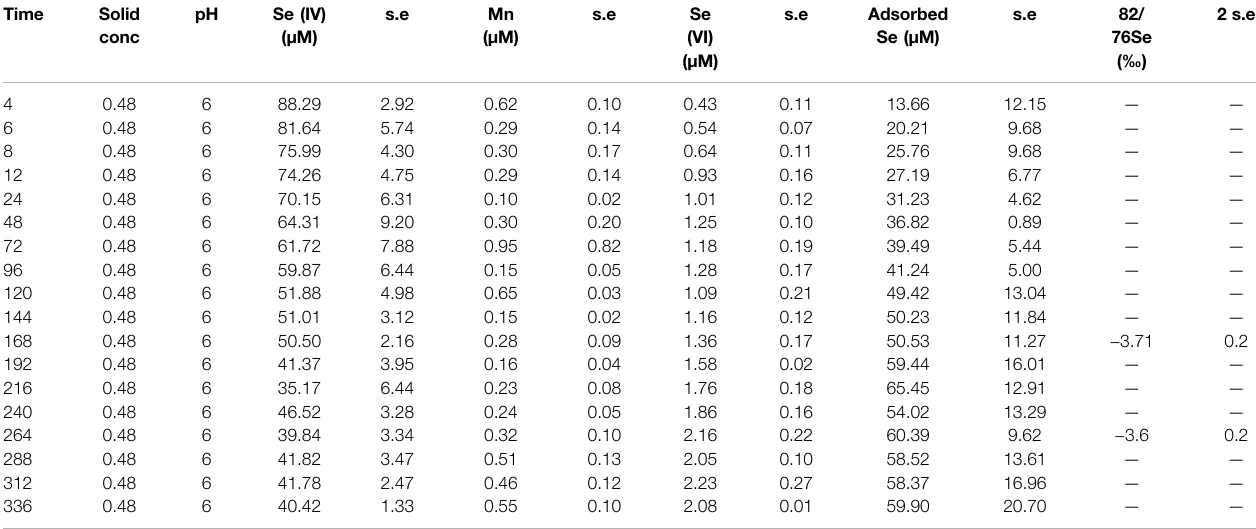
“ s.e ” refers to standard error.